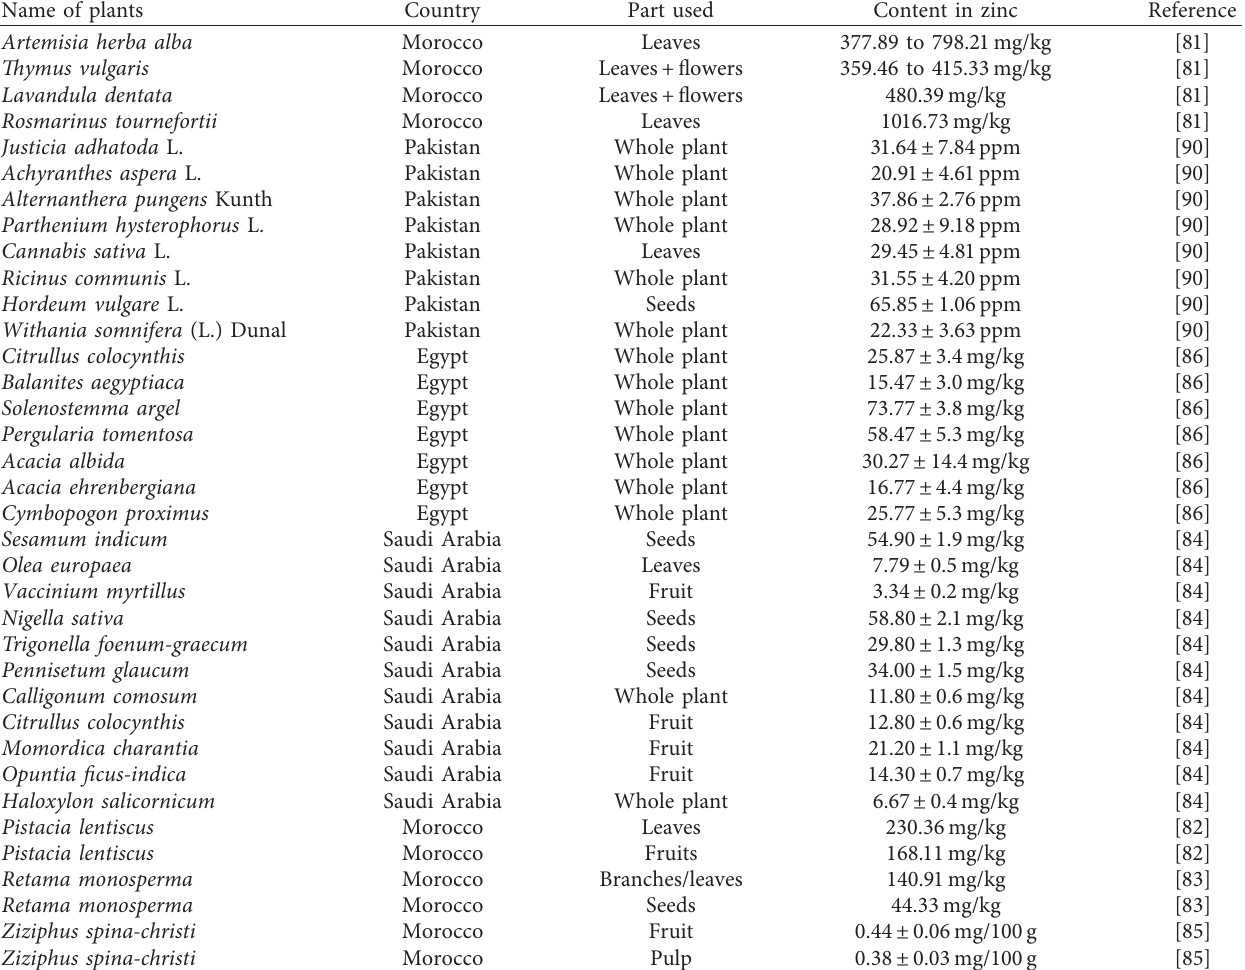
Table 2: The zinc content of medicinal